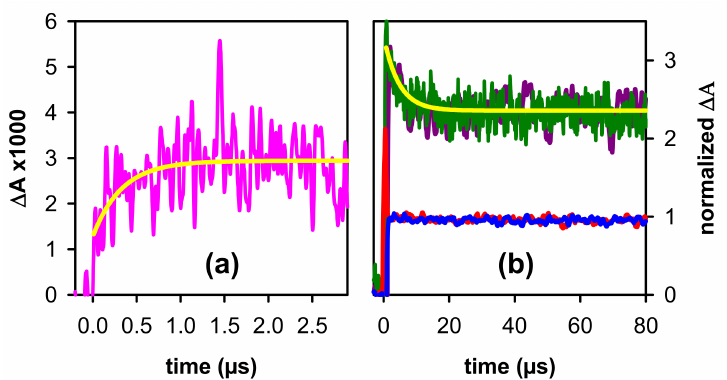
Figure 6. Transient absorption signals recorded for (AG 4 A) 4 /K + at pH 7: ( a ) 605 nm (pink); N 2 O saturated solutions; ( b ) 290 nm (violet), 380 nm (blue), 530 nm (green) and 620 nm (dark red); aerated solutions. Yellow lines correspond to fits with mono-exponential functions: {A 1 (1 − exp(t/ τ 1 )) +A 0 (rise)}and {A 1 exp( − t/ τ 2 ) +A 0 } (decays); τ 1 = 340 ± 40 ns and τ 2 = 4.6 ± 0.4 µ